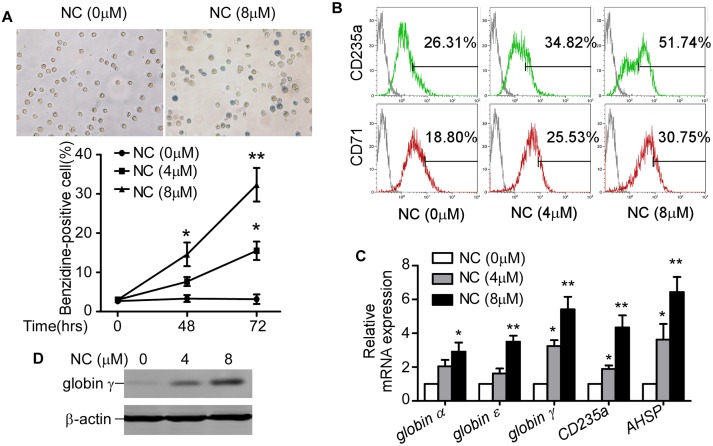
Nitidine Chloride induced erythroid differentiation in K562 cells.(A) K562 cells were treated with 0, 4, 8 μM NC for 48 or 72 hrs, and then benzidine staining was performed. A representative image of benzidine stained cells after treatment with NC for 72 hrs was shown. The percentage of benzidine-positive cells was calculated by counting at least 200 cells from 3 fields under microscope. The values represent the means ± S.E. (n = 3). *, P<0.05. **, P<0.01. (B) K562 cells were treated with 0, 4, 8 μM NC for 3 days, and then subjected to flow cytometry to determine the CD71 and CD235a positive cells. (C) Real-time qRT-PCR was used to analyze the gene expression of globin α, globin ε, globin γ, CD235a and AHSP in K562 cells after NC (4 or 8 μM) treatment for 2 days. β-actin was used as internal control. The values represent the means ± S.E. (n = 3). *, P< 0.05. **, P<0.01. (D) K562 cells were treated with 0, 4, 8 μM NC for 2 days. The expression of globin γ was determined by western blot.